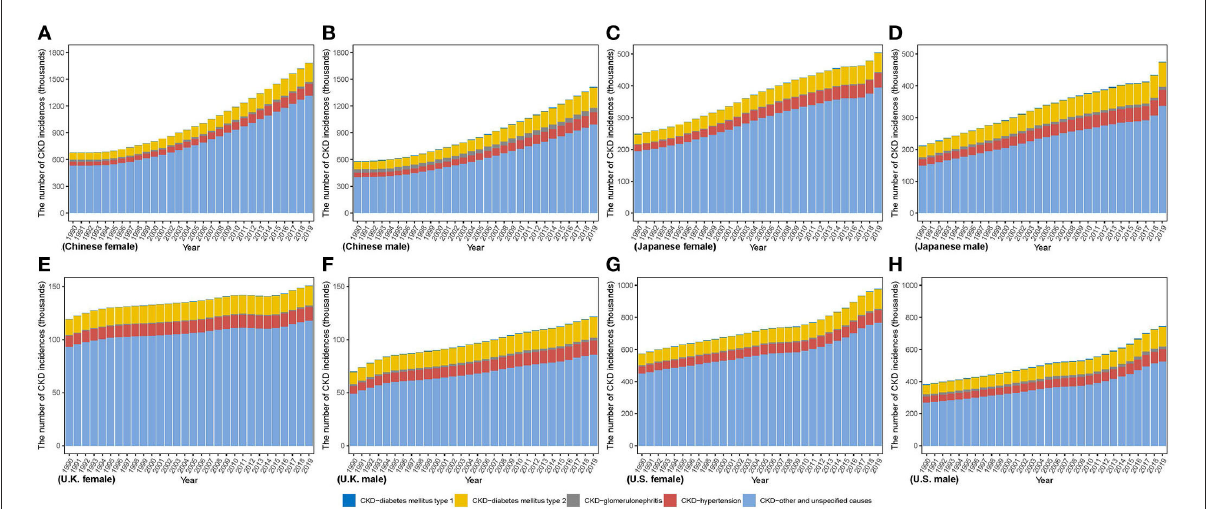
FIGURE1 The number of CKD incidence cases from 1990 to 2019 in (A) Chinese women (B) Chinese men (C) Japanese women (D) Japanese men (E) U.K. women (F) U.K. men (G) U.S. women (H) U.S. men.